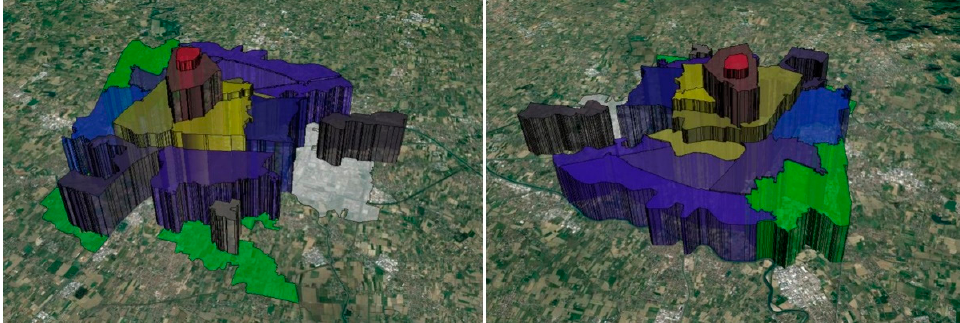
Figure 5. Average values of new dwellings according to the Real Estate Market Monitor of the Italian Revenue Agency as of the second half of 2021: south view ( left panel) and north view ( right panel). The positive sign for the coefficients of two other predictors—distance to the nearest mall (Ml) and the closest beltway ramp (Bw)—likely grasps the same phenomenon, though from a different angle, since malls and beltway ramps are located in suburban areas far from the central districts. Hence, the farther a property is from a mall or a beltway ramp, the closer it is to the city center, and the higher its value is.